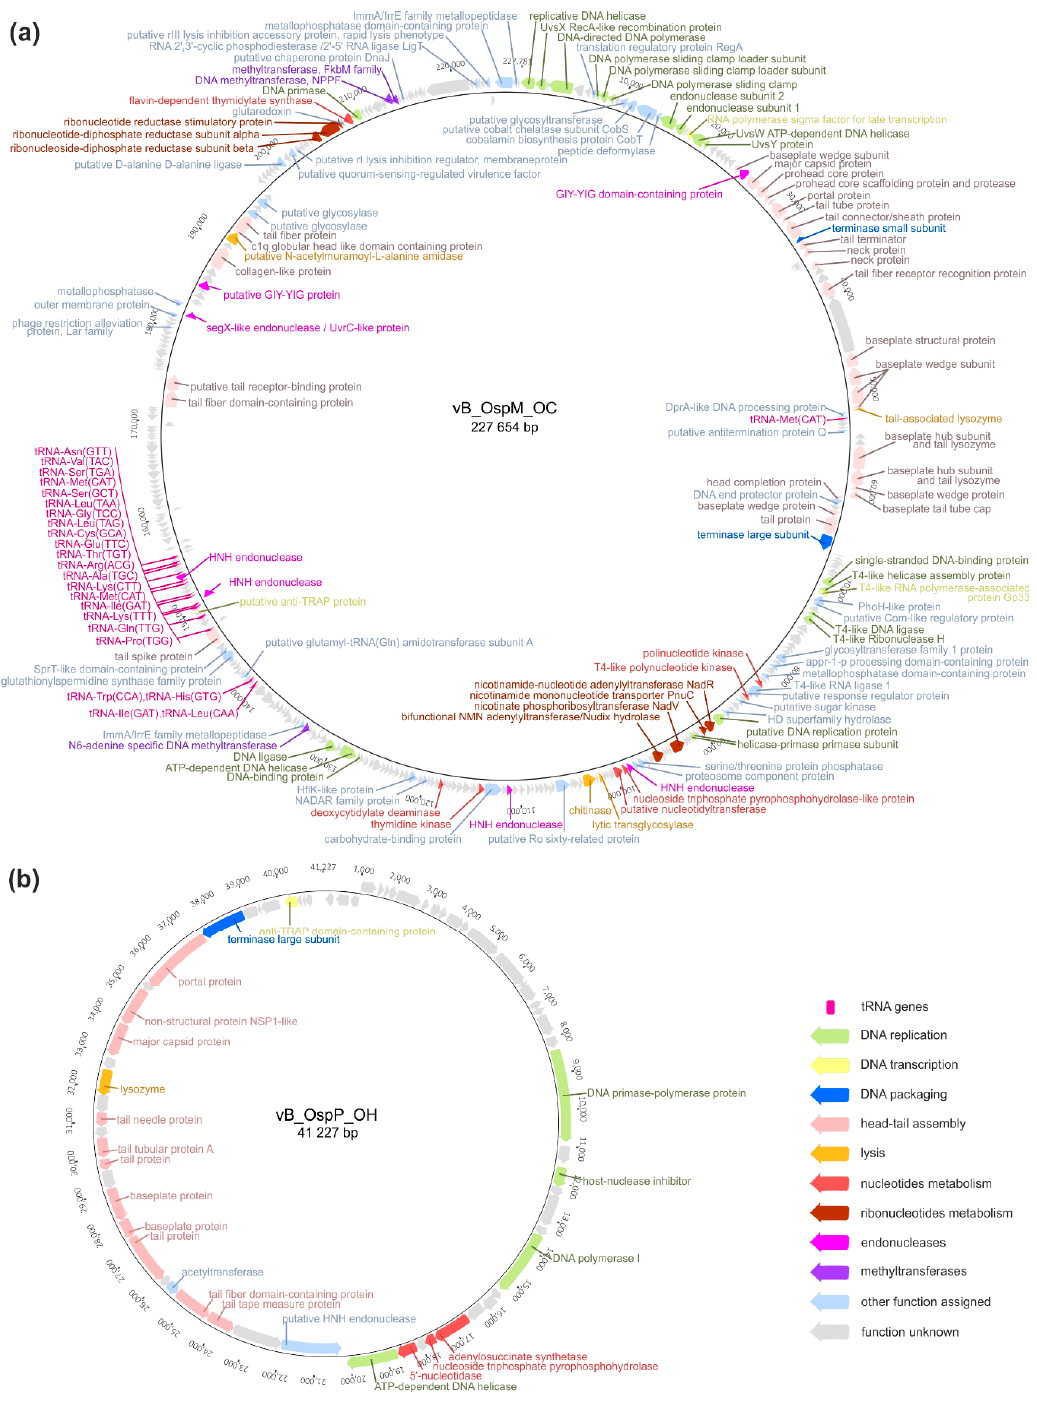
Figure 2. Genome organization of vB_OspM_OC ( a ) and vB_OspP_OH ( b ) phages. Arrows indicate the transcriptional orientation of the genes. All genes, except those encoding hypothetical proteins, have their predicted functions shown as labels next to their respective arrows. Additionally, the arrows were colored as presented in the legend.